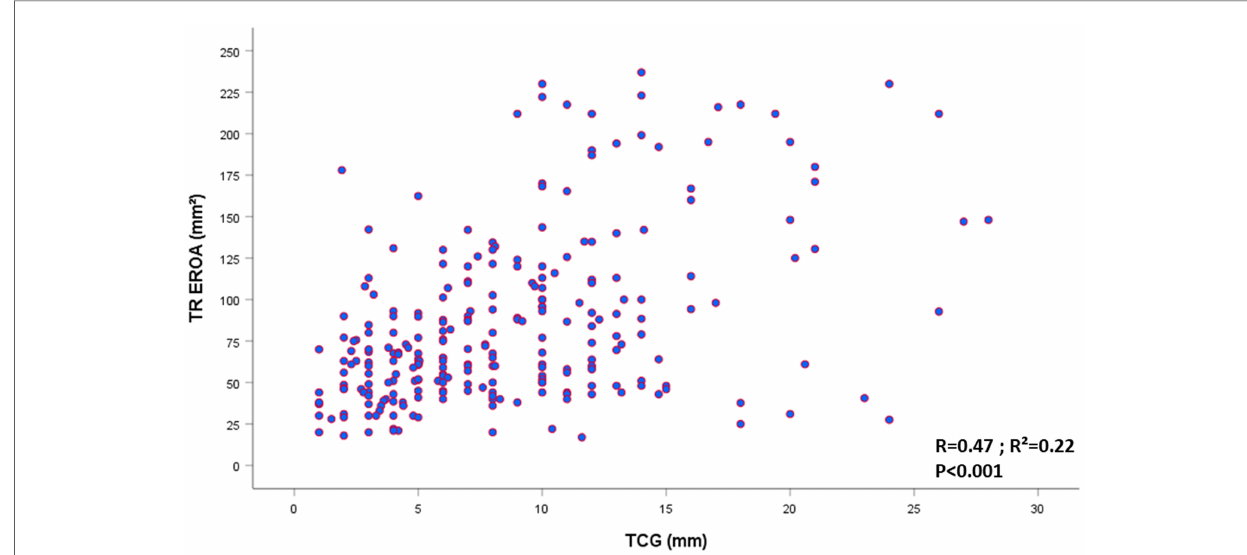
FIGURE 1 Scatter plot representing the relatioship between TREROA and TCG in patients with visible TCG in 2D (270/606; 45%). EROA, effective regurgitant ori fi ce area; TCG, tricuspid coaptation gap; TR, tricuspid